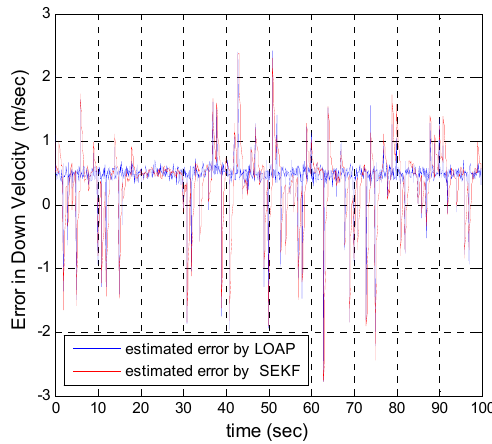
Figure 16. Error estimation of down velocity.